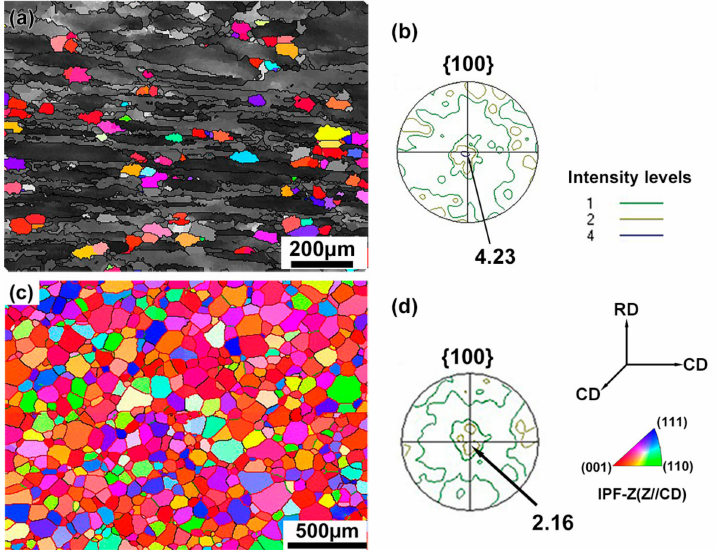
Figure 7. Orientation maps with IPF colors and {100} pole figure of partial recrystallization and complete recrystallization of the sample cooled by 1 K/s after compression with a reduction of 60% at 1153 K and 1 s − 1 strain rate; ( a , b ) cooled to 1123 K and then water quenched, partial recrystallization; ( c , d ) cooled to 1073 K and then water quenched; complete recrystallization; the colored grains are recrystallized grains and the grey grains are deformed